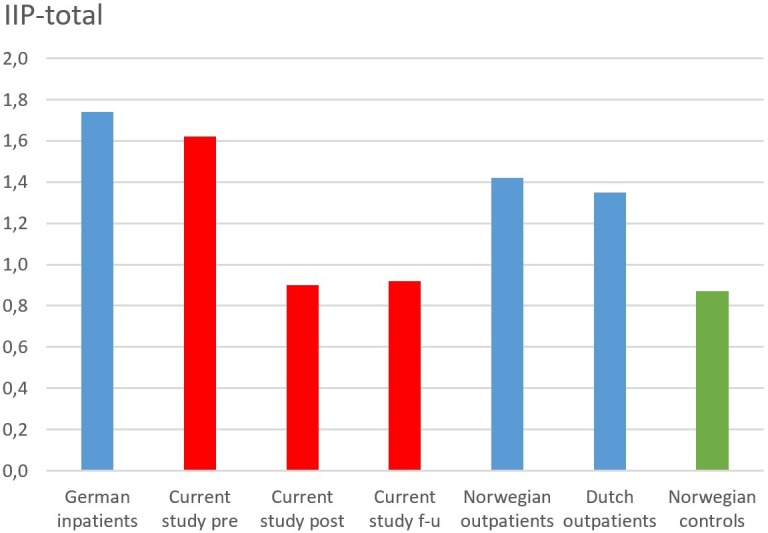
Comparison of studies on pre-treatment levels of interpersonal problems. German inpatients are from Liebherz and Rabung (2014), Norwegian outpatients and controls are from Bjerke et al. (2011), and Dutch outpatients are from Lemmens et al. (2017).